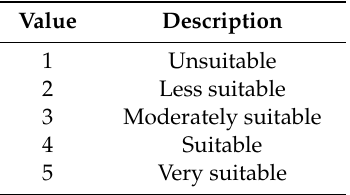
Table 3. Standardization scale of suitability